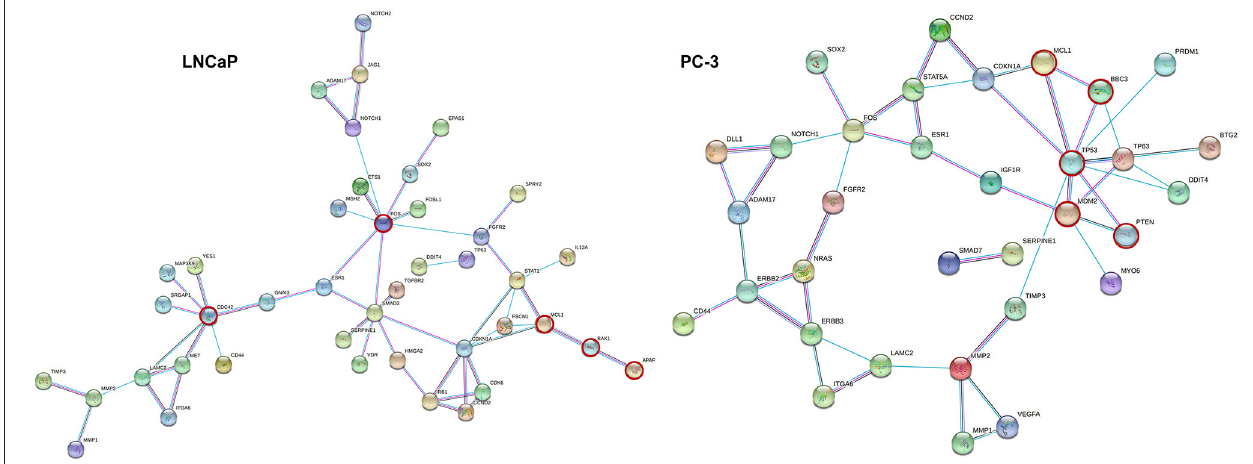
FIGURE 4 | Interaction network of upregulated DEGs generated by STRING software in LNCaP and PC-3 cells. Circles represent genes, and lines represent protein-protein associations. Edges represent protein-protein associations; known Interactions: from curated databases (light blue), experimentally determined (fuchsia); co-expression (black) and protein homology (light